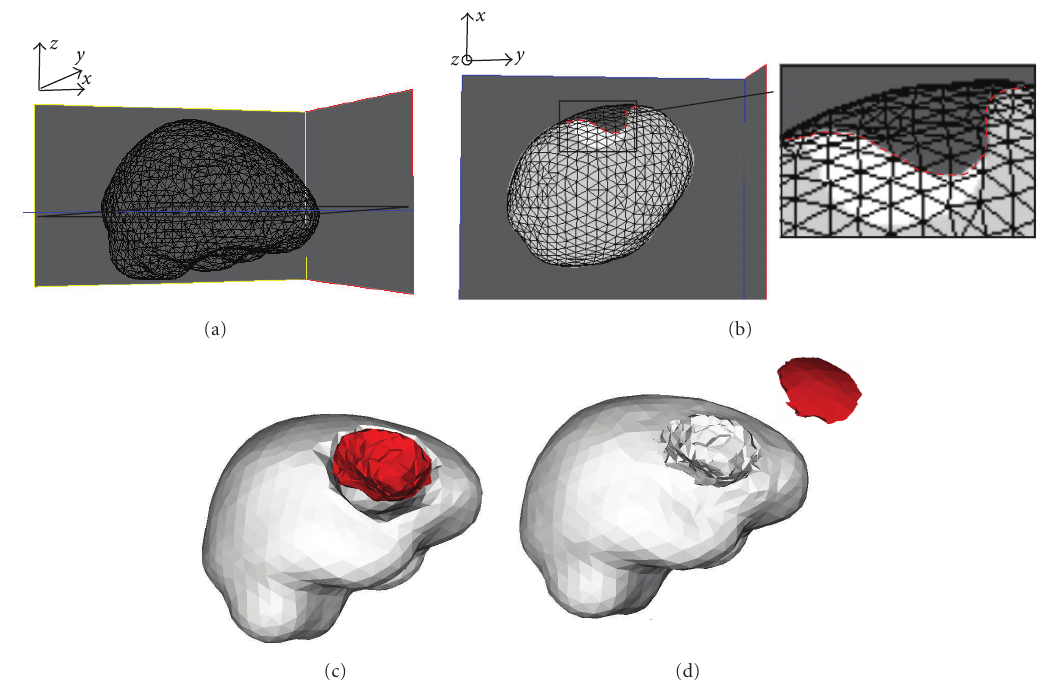
Figure 4: Definition of tissue discontinuity for 2nd resection modeling (first patient case). (a) External surface mesh (of the biomechanical model) with the location of the slice considered in (b). (b) External surface mesh superposed to the healthy-brain region (light gray) and tumor region (white) segmented out from the 3rd iMR image. This superposition allows one to define the tissue discontinuity (red boundary). (c) Surface meshes describing the healthy-brain region boundary (gray) and the tissue discontinuity (red). This tissue discontinuity gives an idea of the part of tumor tissue that was removed by the 1st resection. The gap that appears “between” the gray and red surfaces corresponds to the remaining tumor tissues. (d) Final mesh resulting from the modeling of the 2nd resection using XFEM. The tetrahedra that were added to display separately the two parts of the mesh are only for visualization